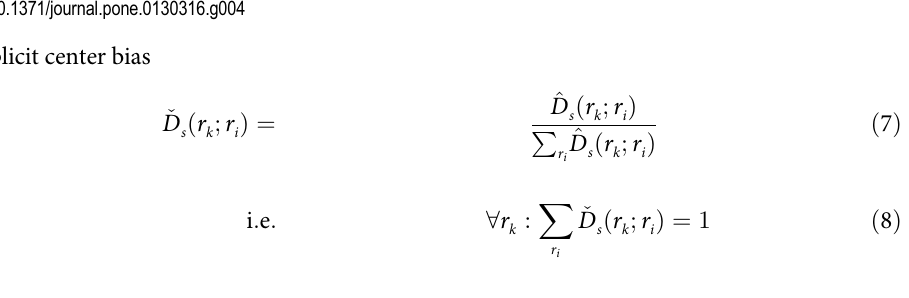
Fig 4. Illustration of the implicit center bias in the method by Cheng et al. [14]. Left: Each pixel shows the distance weight sum, i.e. depending on the centroid location calculated on the Achanta/Liu data set using Felzenszwalb ’ s segmentation method.